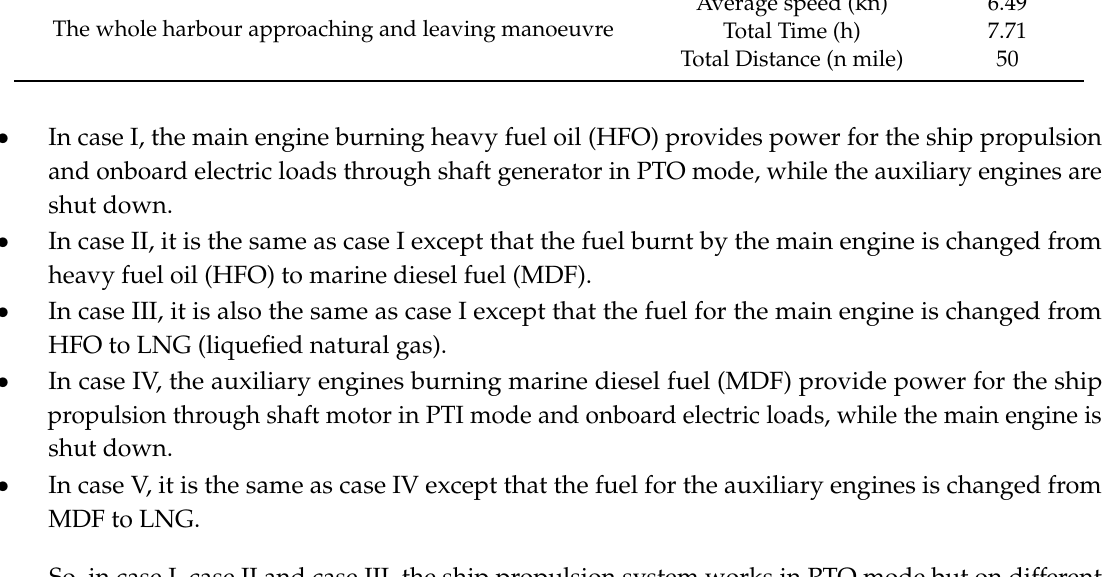
The whole harbour approaching and leaving